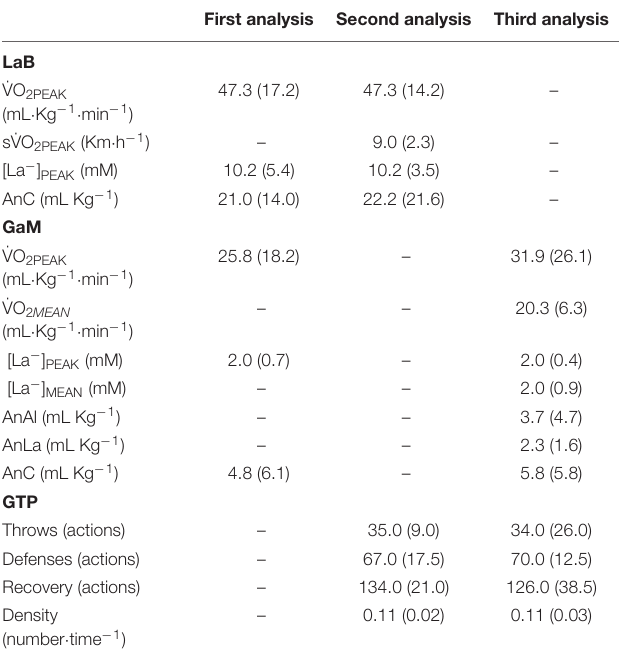
TABLE 1 | Physiological and game technical parameters used in the three analyses.